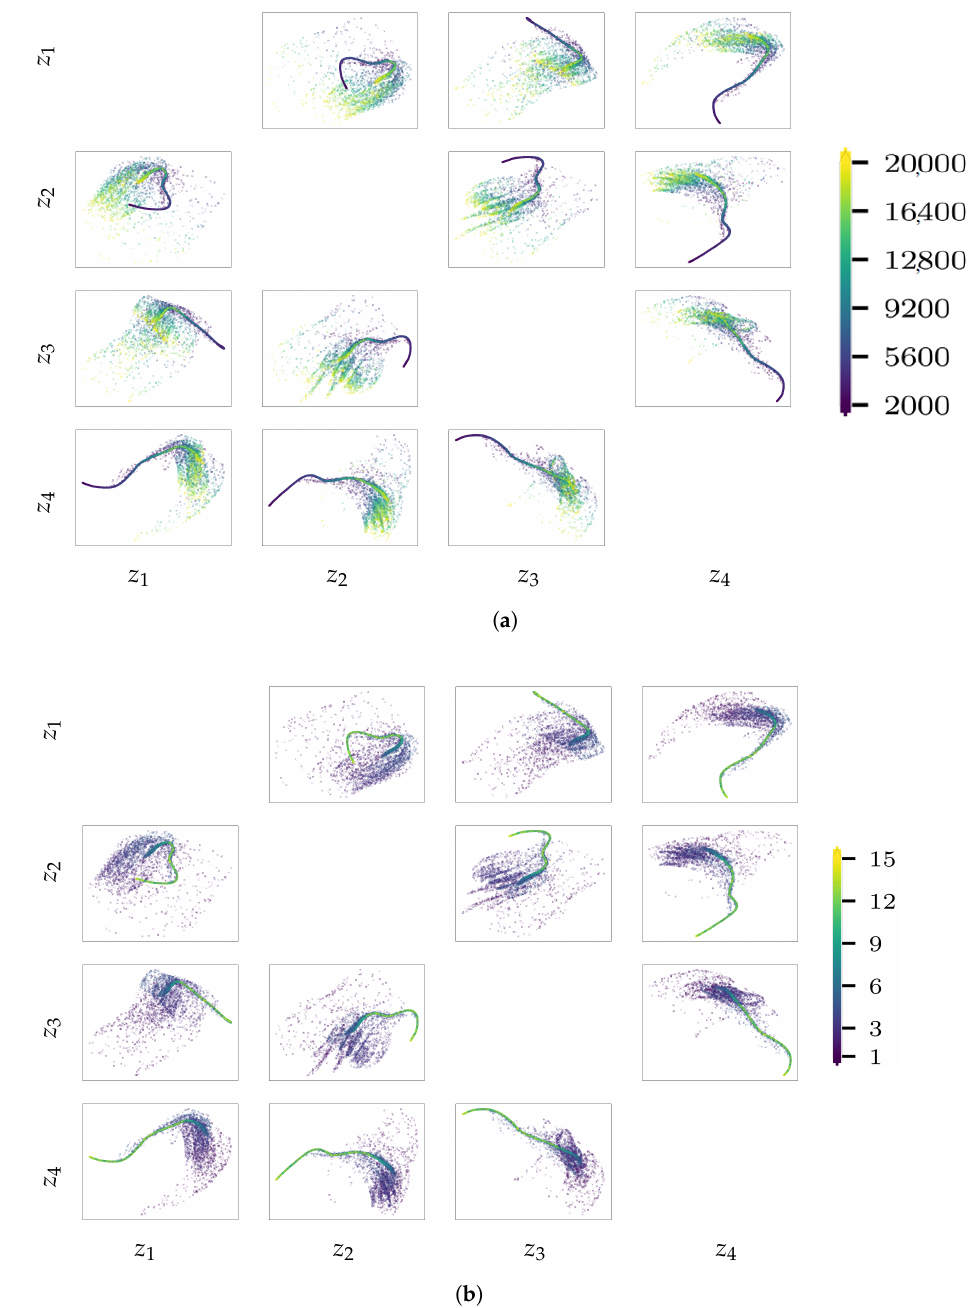
Figure 26. Pirelli Tower, load case 3. Scattered latent representation z determined by enc for the validation set, with coding set by ( a ) the load amplitude α or by ( b ) the load frequency φ